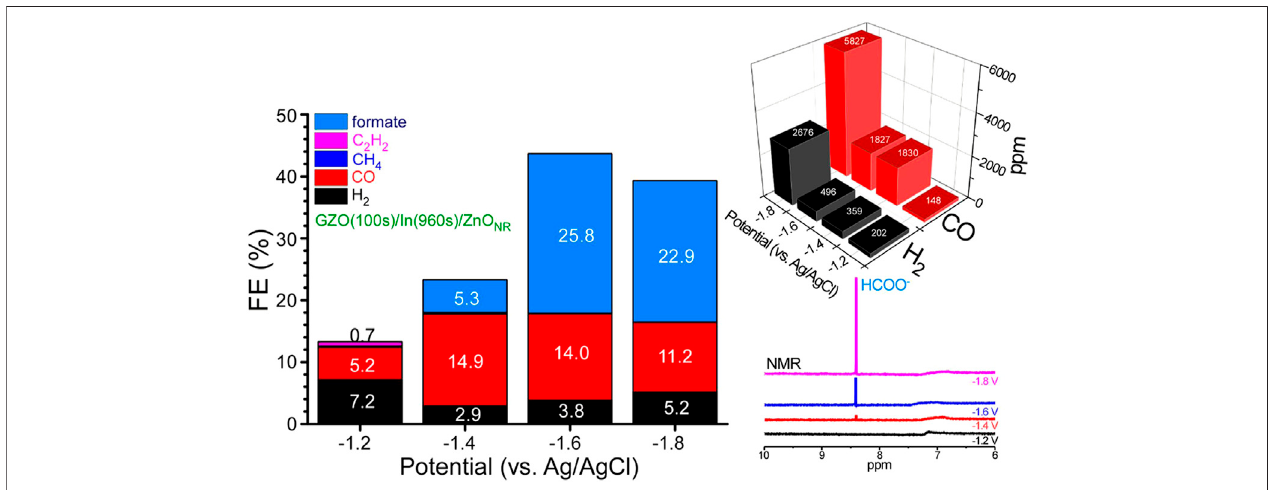
FIGURE 4 | Electrochemical CO 2 reduction FE(%), ppm amounts of H 2 and CO, and the corresponding NMR data for GZO(100s)/In(960s)/ZnO NR at different applied potentials of − 1.2, − 1.4, − 1.6, and − 1.8 V (vs. Ag/AgCl).